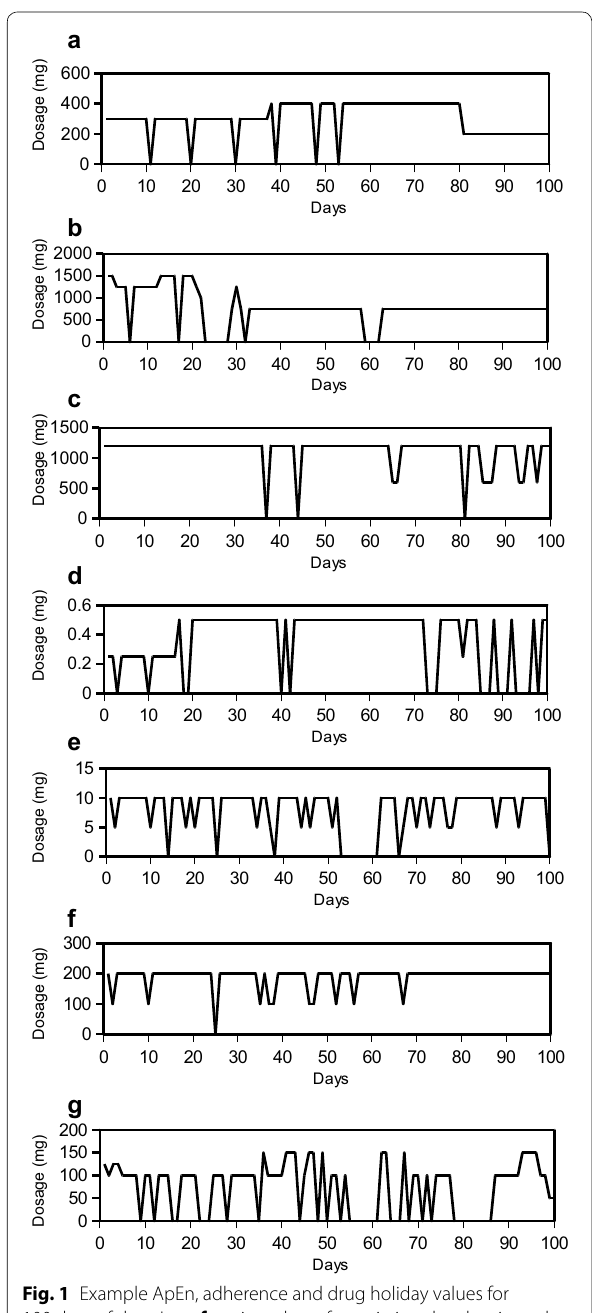
Fig. 1 Example ApEn, adherence and drug holiday values for 100 days of data. In a – f , patients have few missing days but irregular daily dosage (high ApEn). In g , the patient has both a large number of missing days and irregular daily dosage. a Lamotrigine. ApEn 0.3432 with 94% adherence and 0 drug holidays. b Valproate. ApEn 0.4836 with 87% adherence and 2 drug holidays. c Lithium. ApEn 0.3511 with 97% adherence and 0 drug holidays. d Risperidone. ApEn 0.6007 with 80% adherence and 4 drug holidays. e Asenapine. ApEn 0.7117 with 86% adherence and 1 drug holiday. f Lamotrigine. ApEn 0.3756 with 99% adherence and 0 drug holidays. g Lamotrigine. ApEn